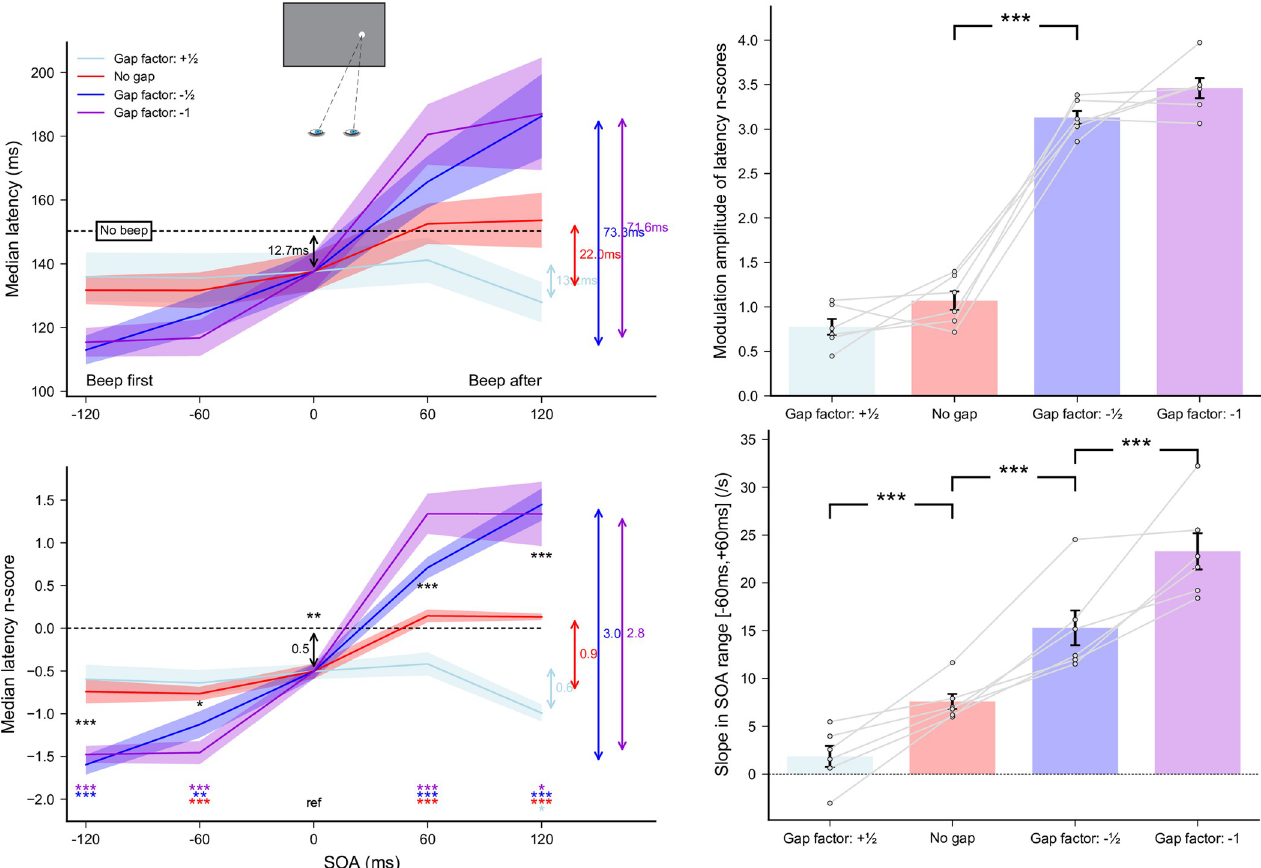
Fig 6. Experiment 2. Effect of various gap compensation factors on saccade latency. (Left panel) Median latencies averaged across participants for each gap factor in {+ ½ , 0, - ½ , -1} as a function of SOA (top) and their corresponding n scores (bottom). Dashed lines correspond to the No beep baseline condition. Statistics performed on the n scores included a single sample t-test to compare the 0-ms SOA reference condition with the No beep condition (black arrow), and for each gap factor separately, paired t-tests compared this reference with each SOA condition (colored stars for each SOA above the X-axis). Three stars indicate highly significant differences after Bonferroni correction (p < 0.00294) while single stars and two stars indicate significant differences with less (p < 0.005) or without correction (p < 0.05). (Right panel) Modulation amplitude of the latency median n scores (top) and slopes of the linear regressions within the range [ − 60 ms, +60 ms] (bottom) computed for each gap factor. Grey lines show individual results and error bars indicate inter-individual SEM.